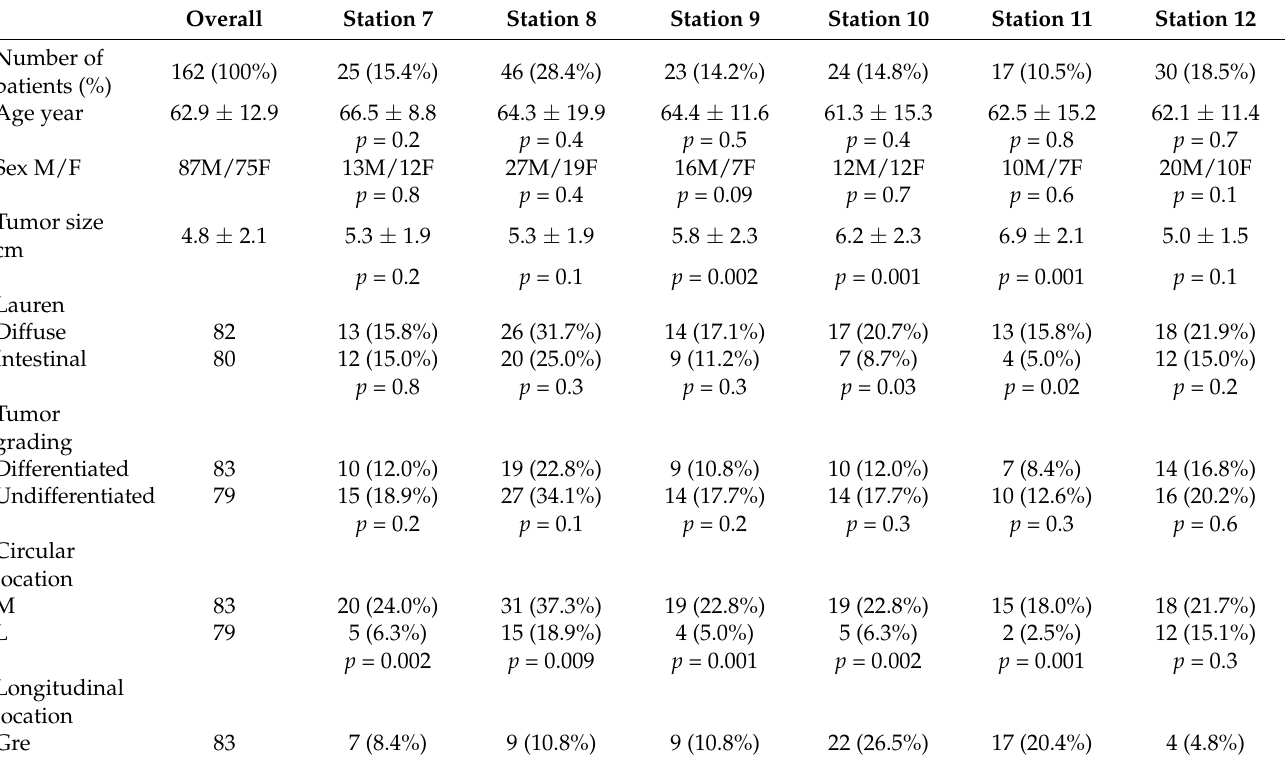
Table 6. Incidence of LNs metastasis per nodal station 7 to